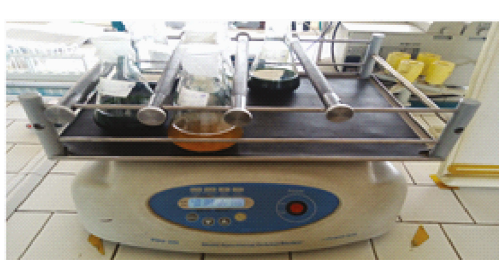
Figure 4: (a) BioSan multifunctional orbital